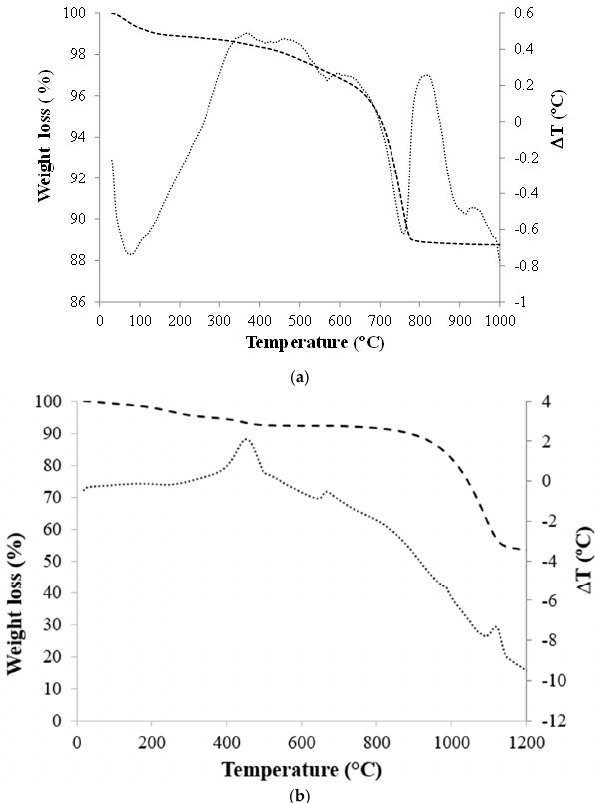
Figure 3. Thermogravimetric and differential thermal analysis (TGA-DTA) of ( a ) raw clay and ( b ) AFD waste.